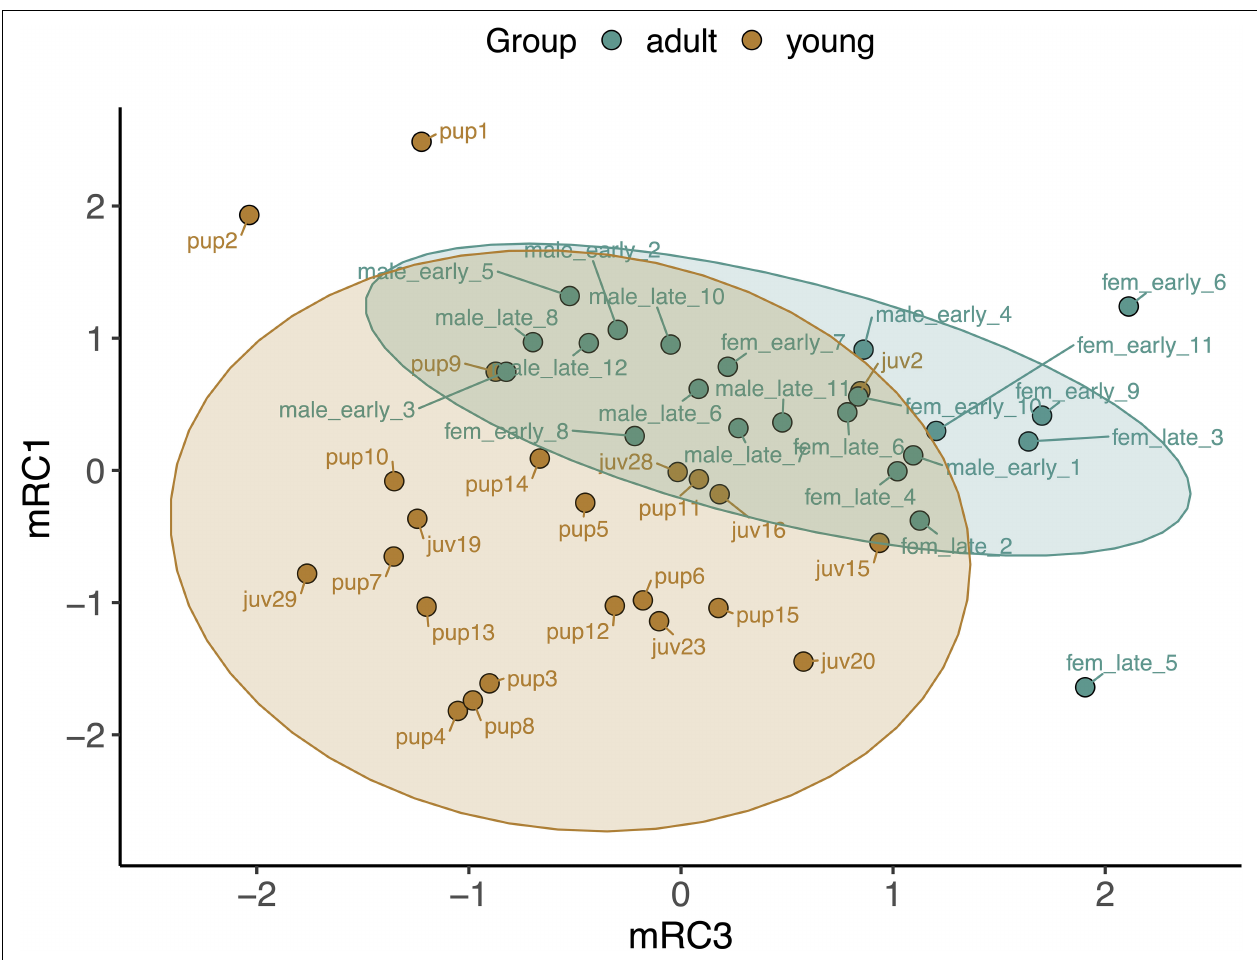
FIGURE 3 | Principal components analysis loading plot for rotated components describing baseline gene expression associated with CO signaling and cytoprotection in skeletal muscle of NES pups, juveniles, and adults. mRC1: GPX4 , PRDX6 , PRDX1 , SIRT1 ; mRC3: HMOX1 , BVR , GPX3 , PRDX1 . Ellipses show 95% confidence intervals for young (pups and juveniles, n = 24; brown) and adult ( n = 22; blue)